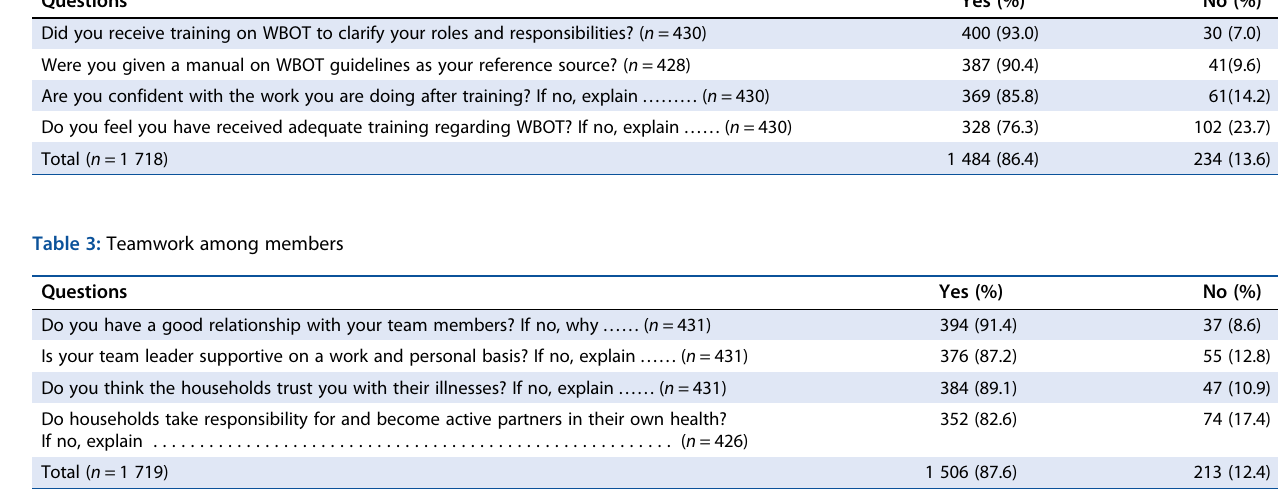
Table 2: Training of CHWs on WBOT services